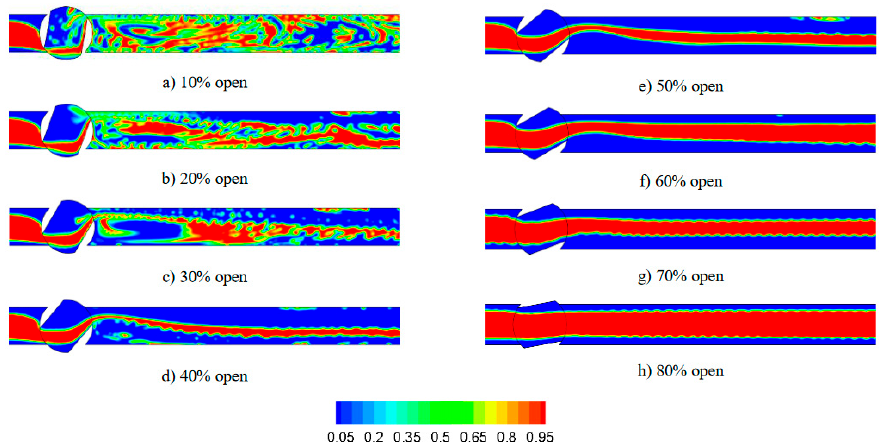
Figure 11. Comparison of di ff erent open rates of the valve [53]. (Red for oil and blue for water.)